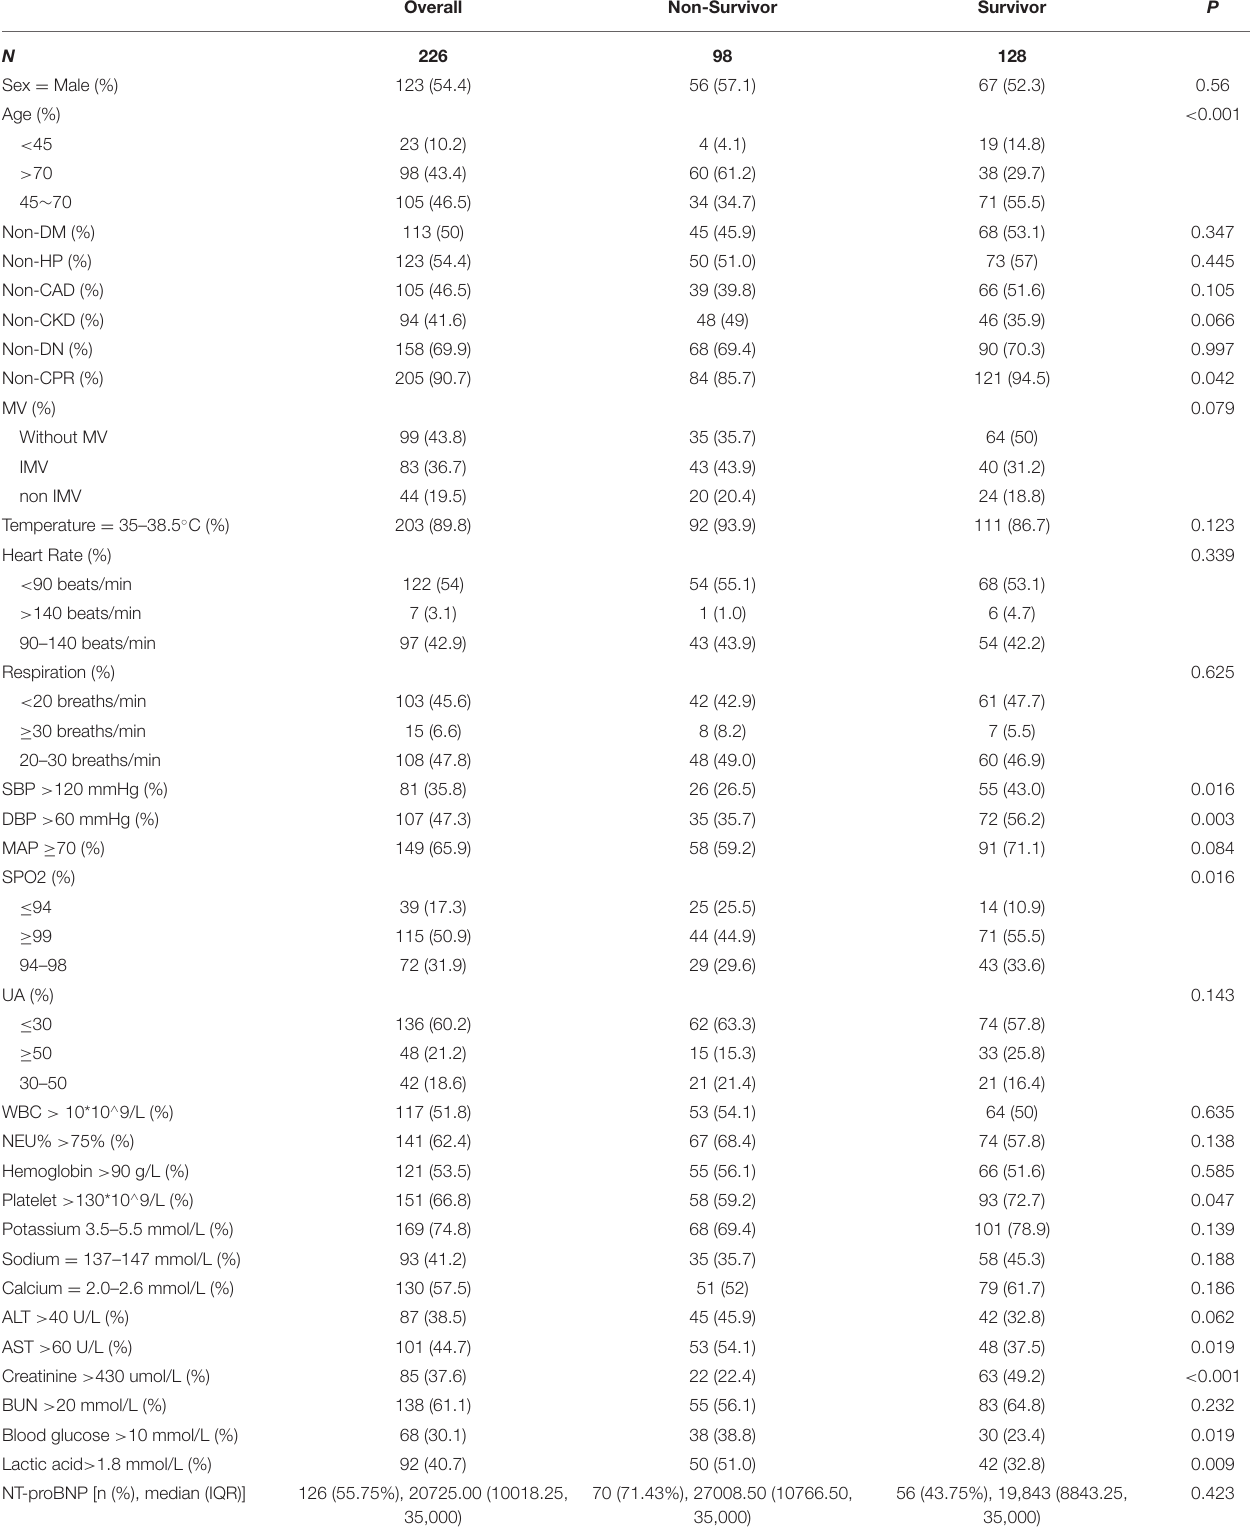
TABLE 1 | The baseline characteristics of the survivor cohort and the non-survivor cohort. Overall Non-Survivor